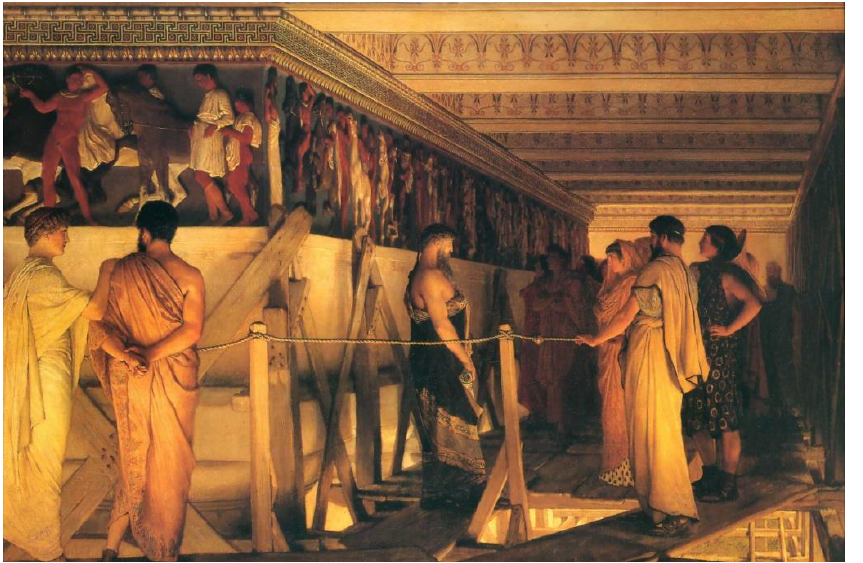
Figure 4. Oil on canvas painting by Lawrence Alma-Tadema, Phidias Showing the Frieze of the Parthenon to his Friends (1868). The Greek sculptor, Phidas, is depicted in the centre of the composition showing the frieze to Pericles and his mistress Aspasia. In the foreground to the left stand the philosopher Socrates and the young Alcibiades. Birmingham Museum and Art